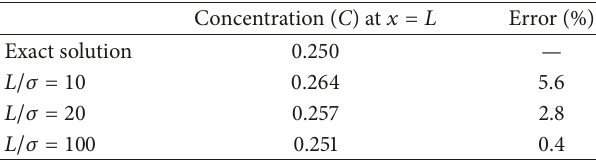
Table 1: Comparison of solutions from a simple set of NPP